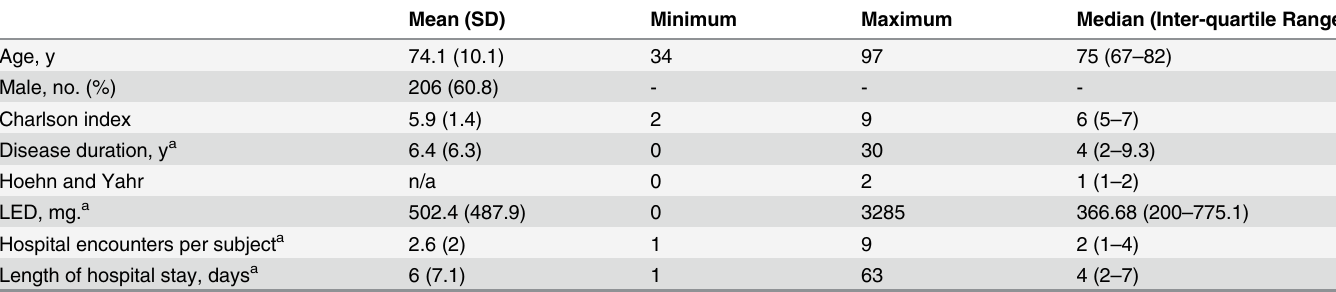
Table 1. Demographic and clinical characteristics of